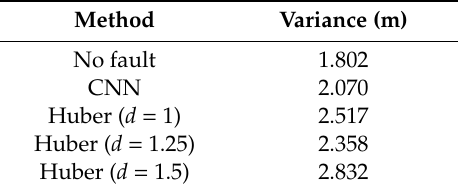
Table 3. Variance of position error corresponding to gradual